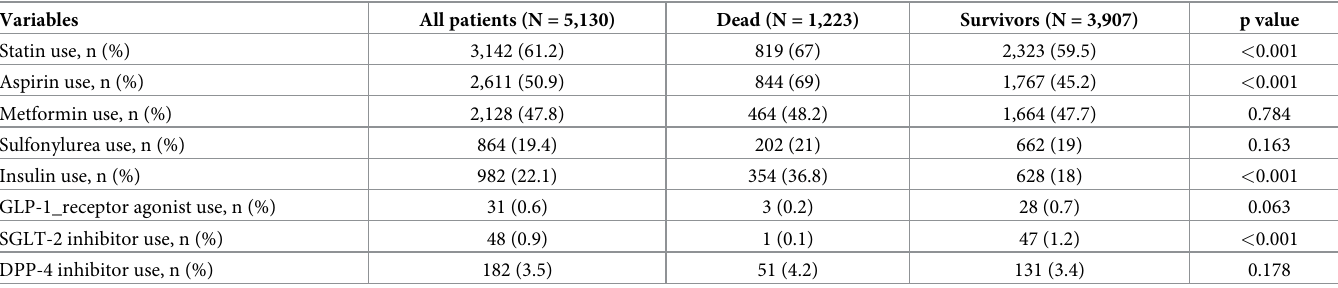
Table 2. Baseline treatments of study participants overall and by survival status.